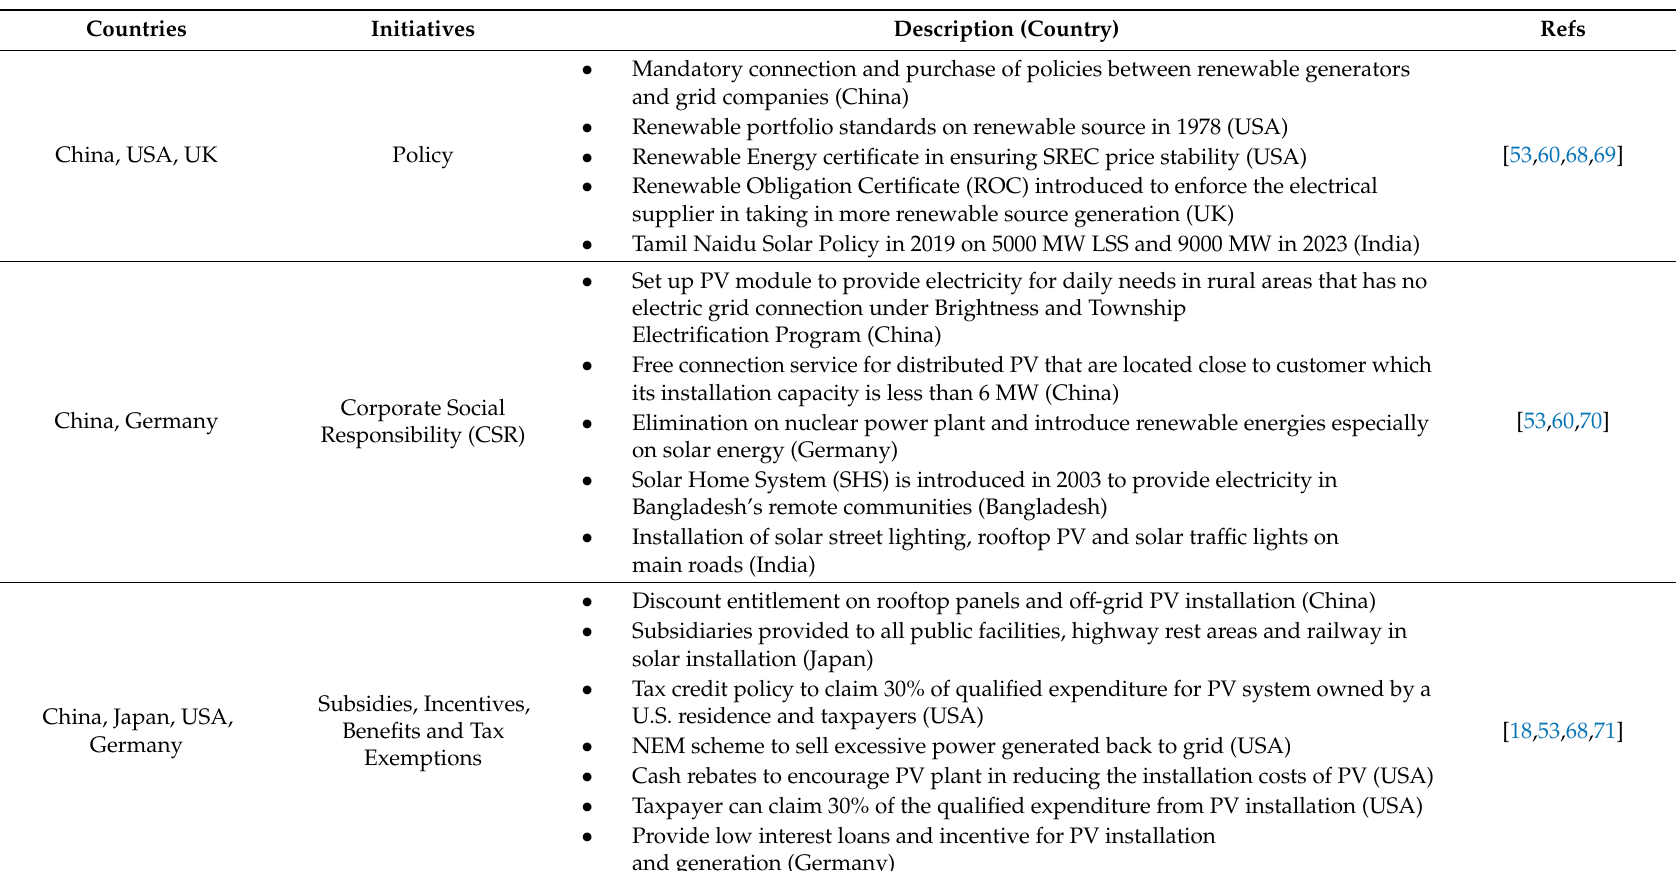
Table 1. Initiatives by countries in promoting solar